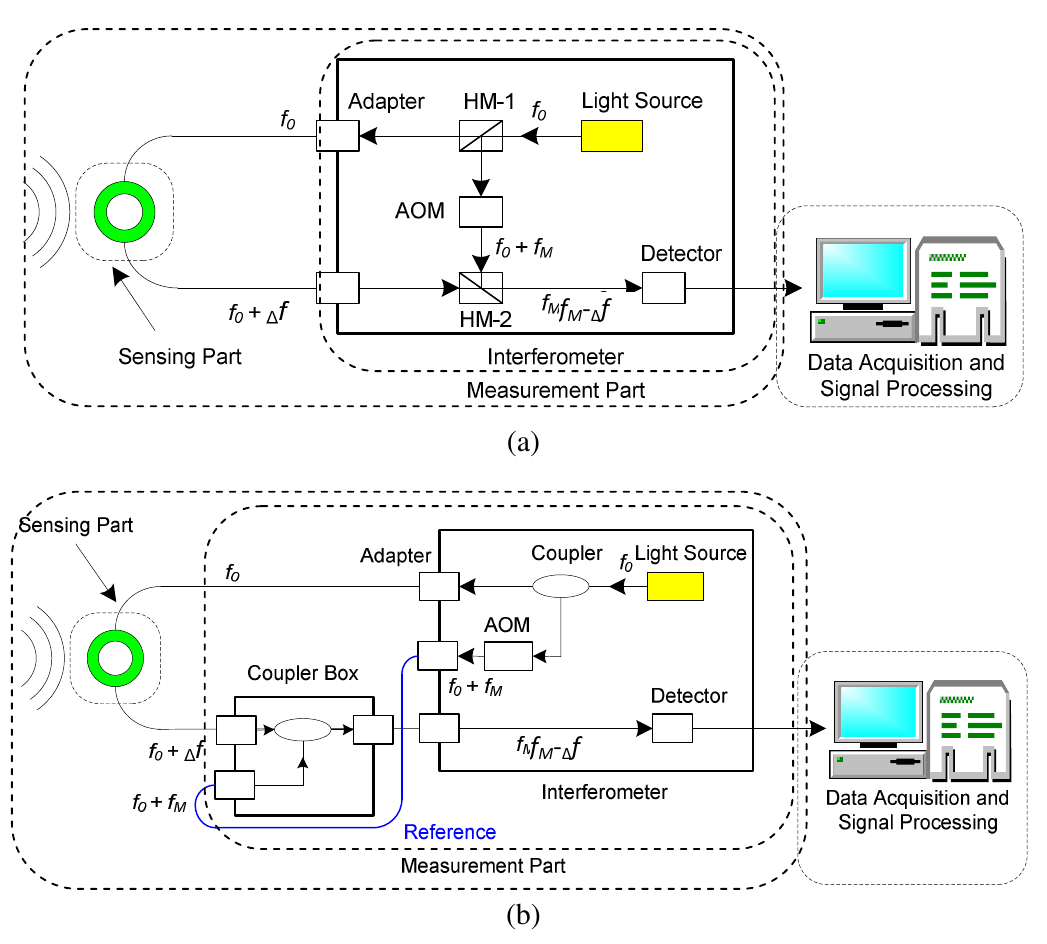
Figure 2. Principles of interferometers using (a) the He-Ne laser and (b) infrared semiconductor